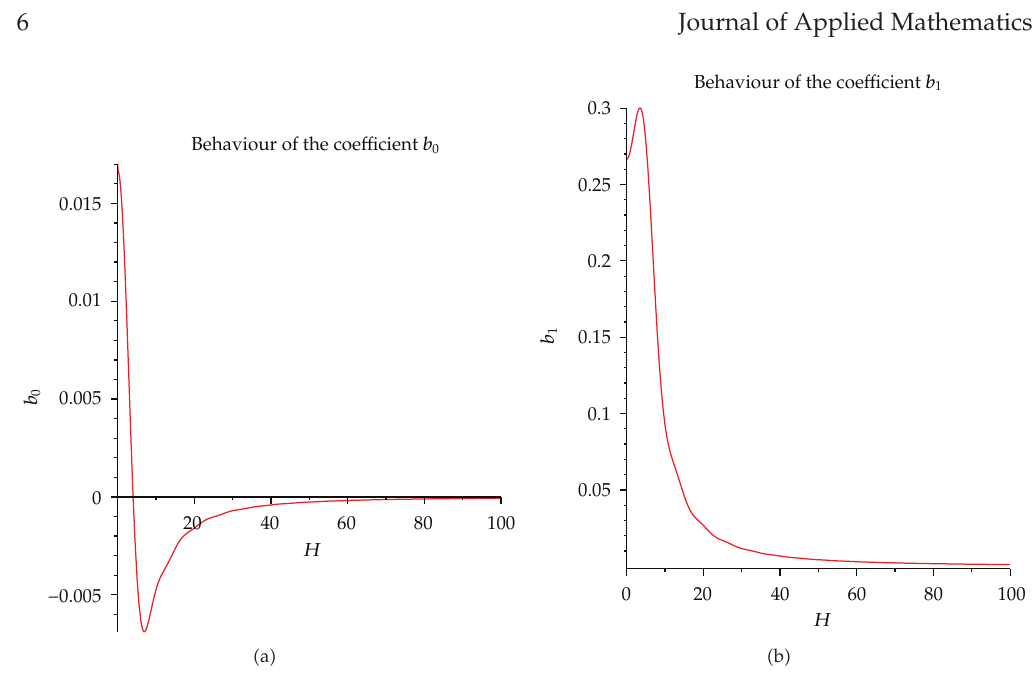
Figure 1: Behaviour of the coe ffi cients of the new proposed method given by (cid:4) 3.5 (cid:5) for several values of H (cid:6) ωh